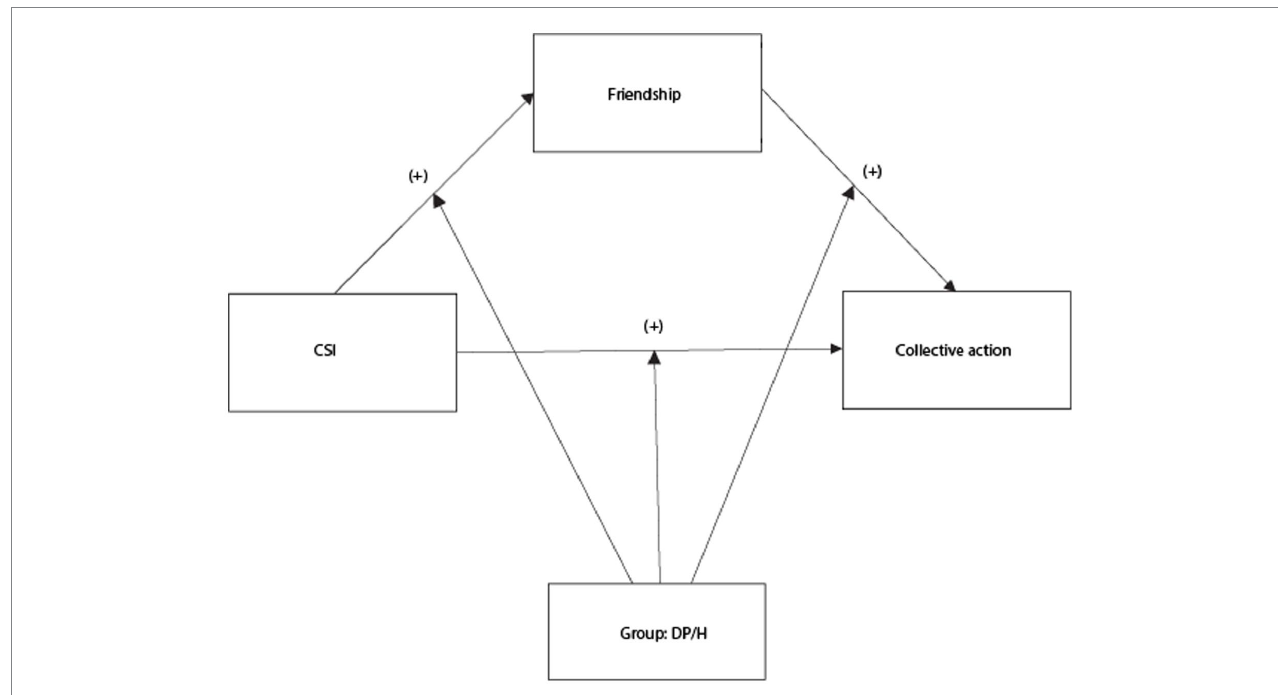
FIGURE 1 Hypothetical moderated mediation model.